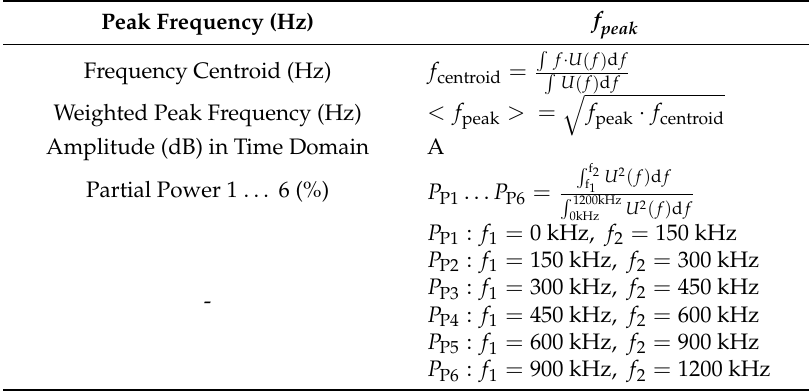
Table 1. Initial feature